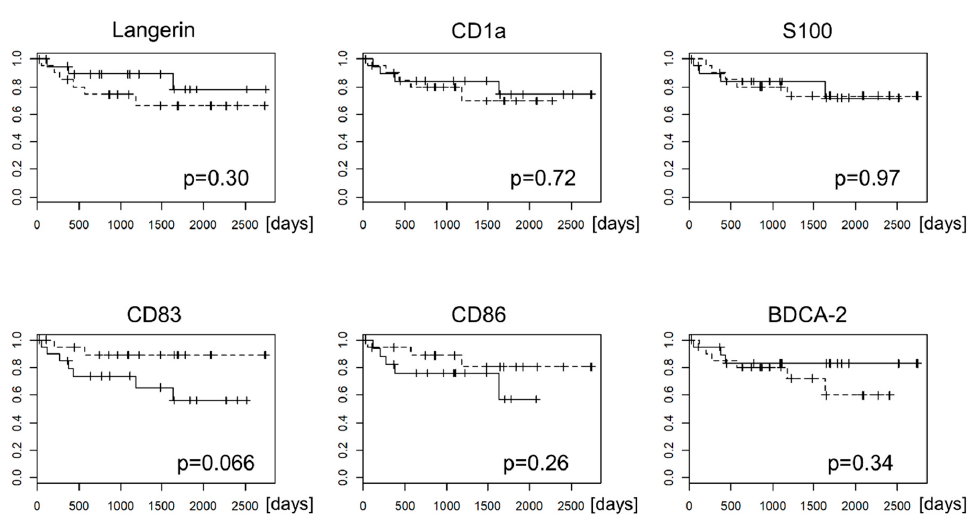
Figure 6. Kaplan–Meier curve of overall survival of patients with EBVaGC. Gastric cancer cases were divided into two groups according to the number of infiltrating DCs that express the indicated DC markers. The cases with less CD83-positive DCs tended to have worse prognosis, although this was not statistically significant ( p = 0.06, log-rank test).